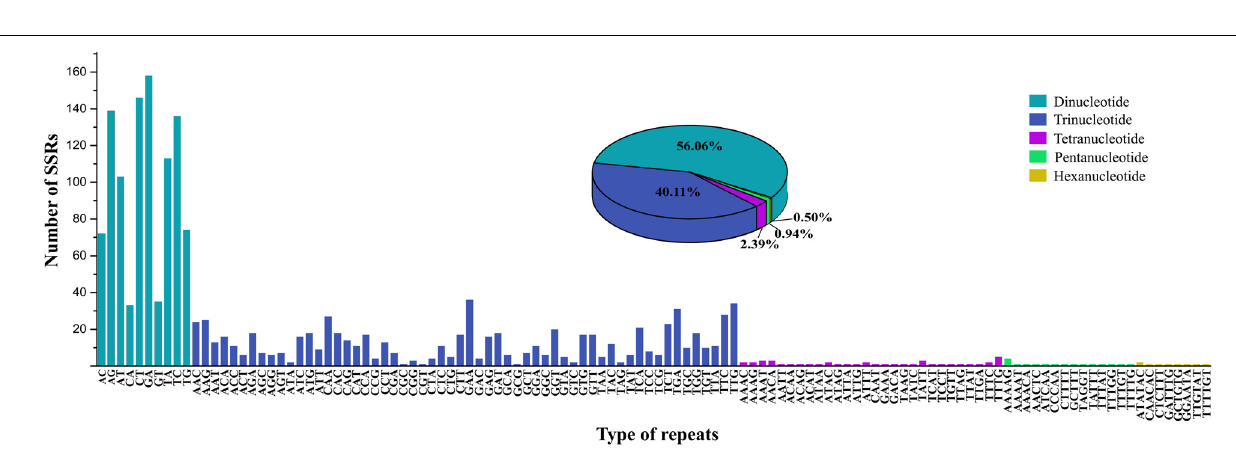
FIGURE 5 | The distribution information of the polymorphic nuclear simple sequence repeats (nSSRs) within the genus Tiarella . The pie chart shows the overall prevalence of repeat lengths; the histogram shows the frequency distribution of prevalent repeat